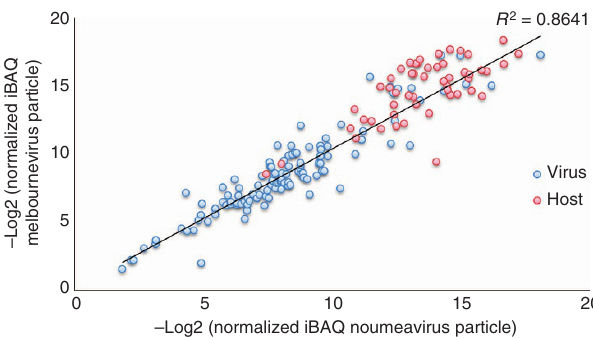
Figure 6 | Proteomic analyses of Noumeavirus and Melbournevirus virion compositions. Comparison of the abundances of host encoded (red) and virally encoded orthologous proteins (blue) in Noumeavirus and Melbournevirus. Higher values correspond to lower protein abundances. The Pearson correlation coefficient only refers to the relative abundances of viral proteins ( P -value computed using the Pearson’s product moment correlation test).